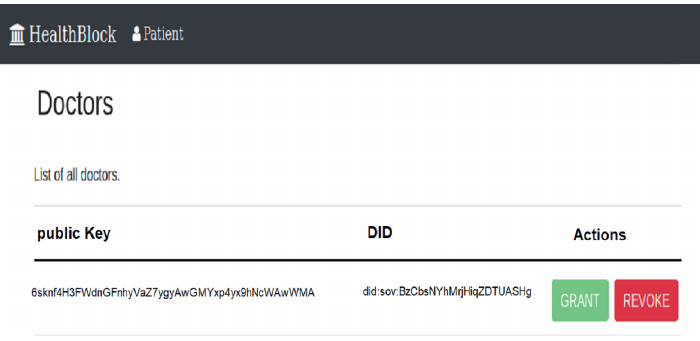
Figure 9. The doctor Alice asks Bob to prove that he is the owner of public key.